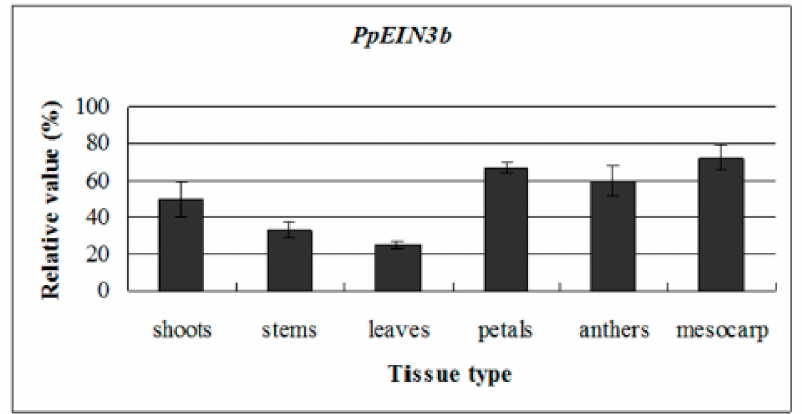
Figure 3. qRT-PCR analysis of expression of PpEIN3b in pear. Total RNA was extracted from shoots, young stems, young leaves, petals, anthers, and mesocarp. Relative value of expression of PpEIN3b in pear tissues is shown as a percentage of PpUBI expression. Mean values and standard deviation (SD) (bar) are shown from three independent